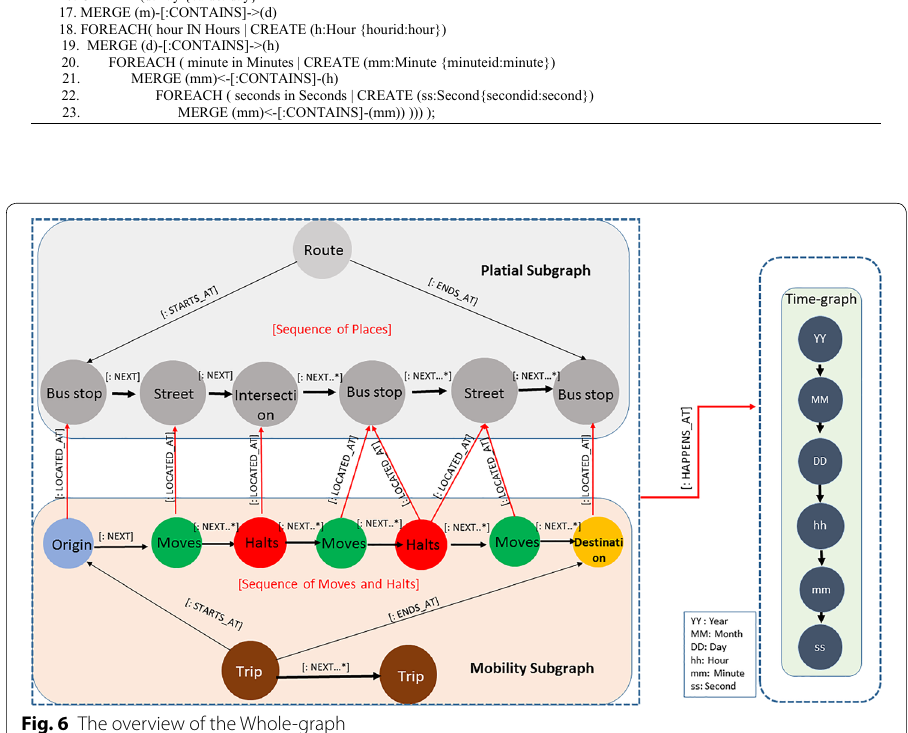
Fig. 6 The overview of the Whole-graph